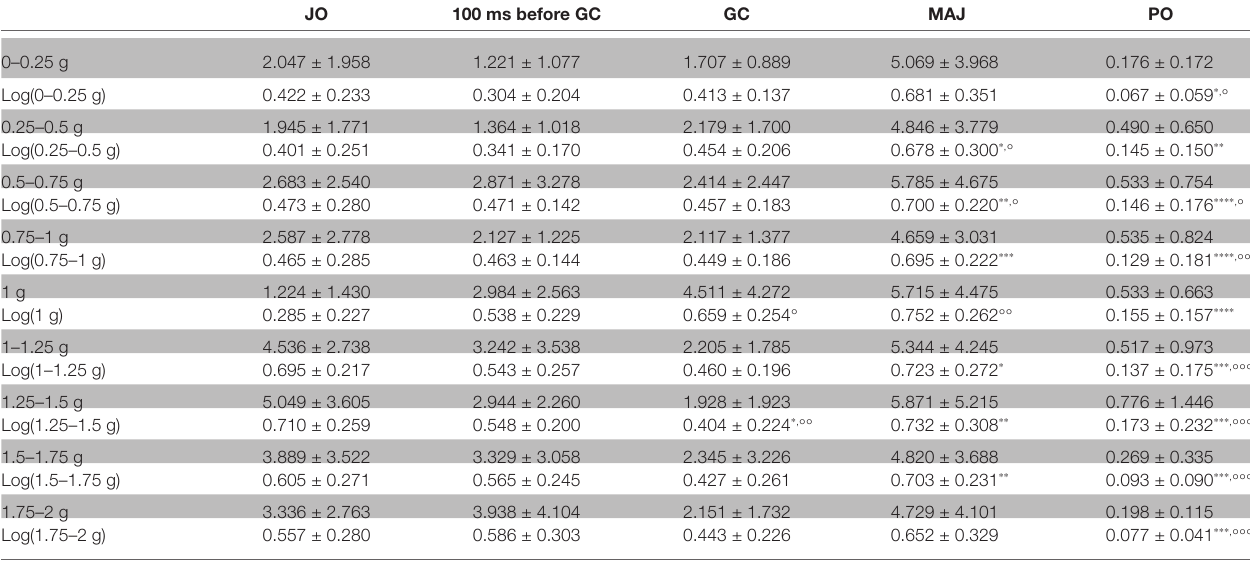
Values are shown as grand means of three jumps per gravity level per subject ± SD. Raw data (gray rows) and transformed data (white rows) are reported. * p < 0.05 vs. previous jump time point; ** p < 0.01 vs. previous jump time point; *** p < 0.001 vs. previous jump time point; **** p < 0.0001 vs. previous jump time point;